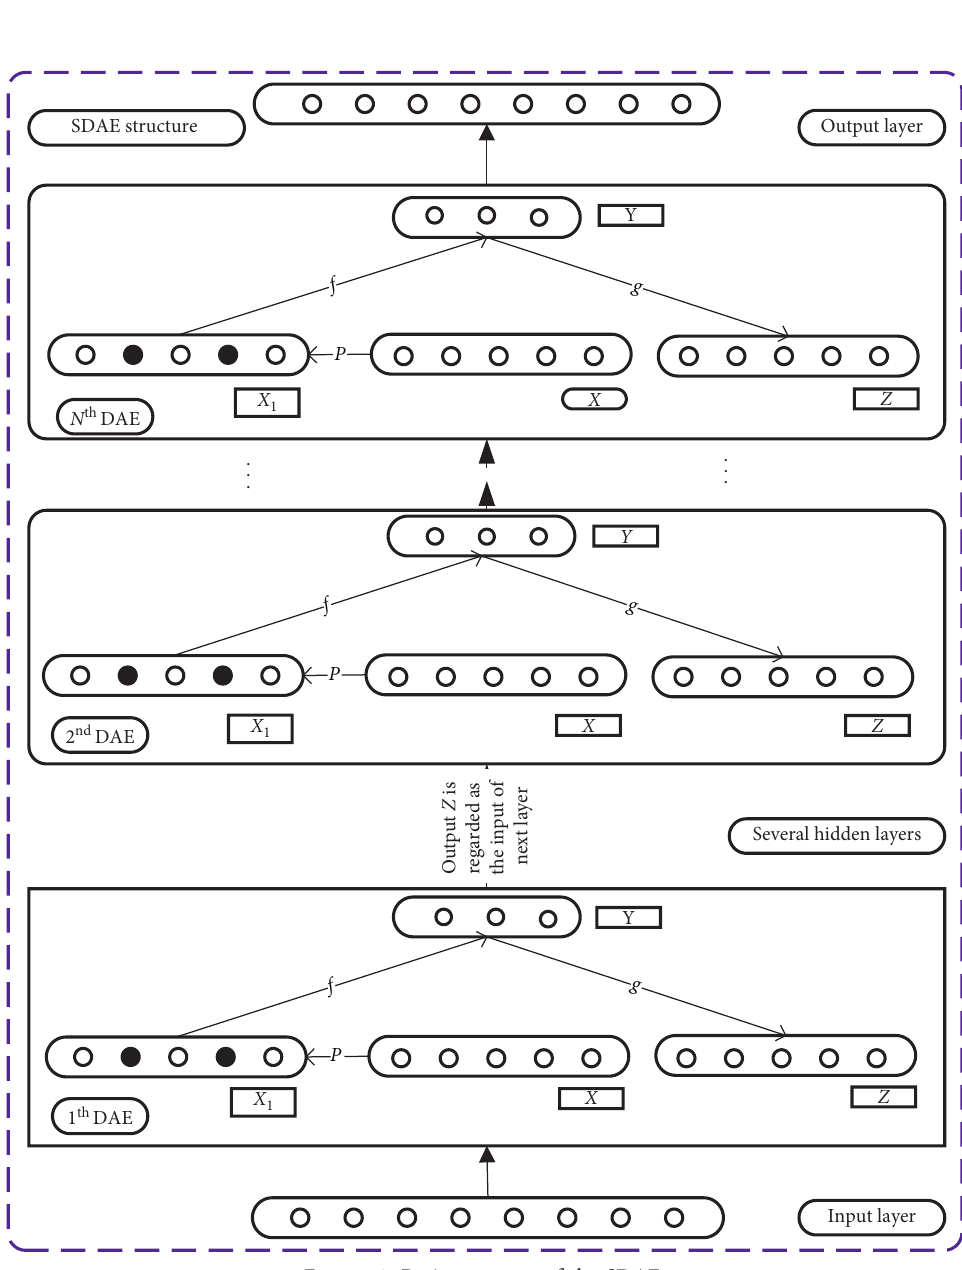
Figure 2: Basic structure of